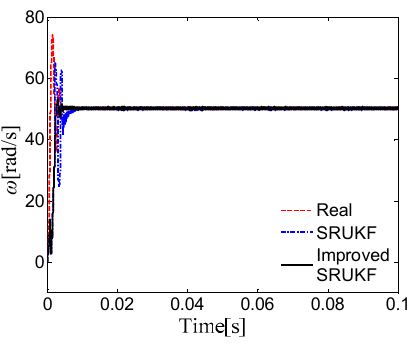
Figure 2. Speed estimation at 50 rad/s.